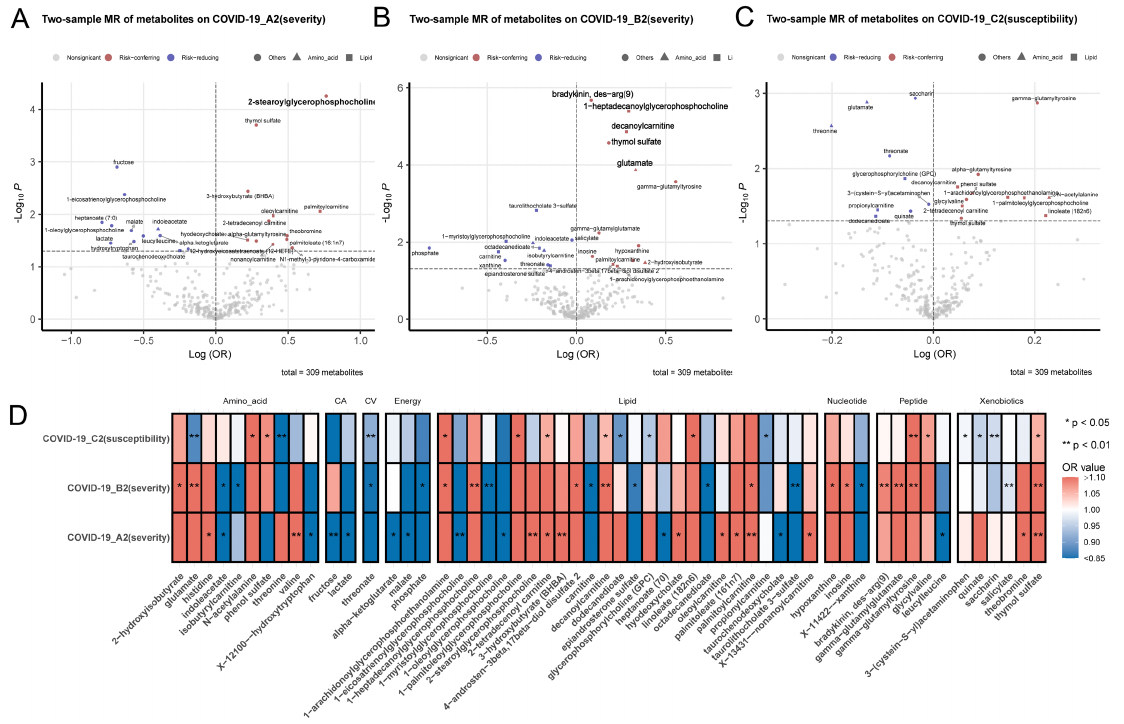
Figure 2. Causal associations between human serum metabolites and COVID-19 phenotypes. ( A – C ) Volcano plots that include both odds ratios (OR) in log scale and P-values estimated by the inverse- variance weighted method (multiplicative random-effects model) for each COVID-19 phenotype. Six metabolites that passed the Bonferroni correction (P IVW < 0.05/302 = 1.66 × 10 −4 ) are shown in boldface type. ( D ) Heatmap of the 56 metabolites that showed causal association with at least one COVID-19 phenotype at nominal significance (P IVW < 0.05). CA: carbohydrate; CV: cofactors and vitamins.